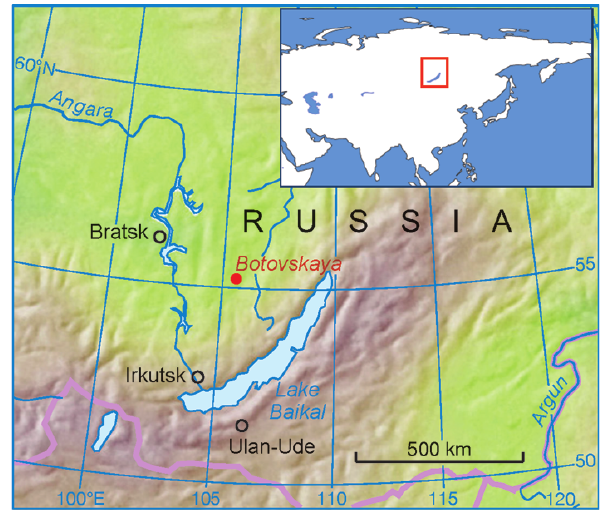
Fig. 1. Map of Siberia, showing the location of Botovskaya